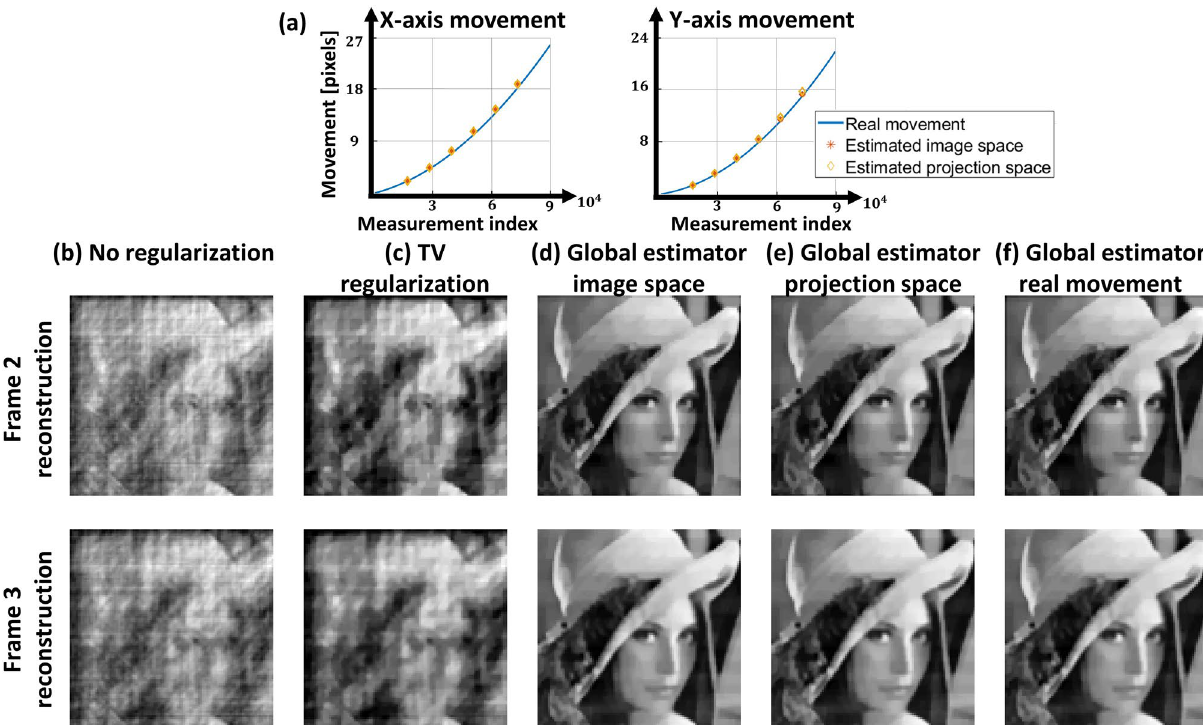
Figure 4. Reconstruction of Lena image undergoing translation with accelerating velocity. ( a ) Movement of the image during measurements and estimated movement. ( b – f ) Reconstruction of the second and third frames with different reconstruction algorithms.